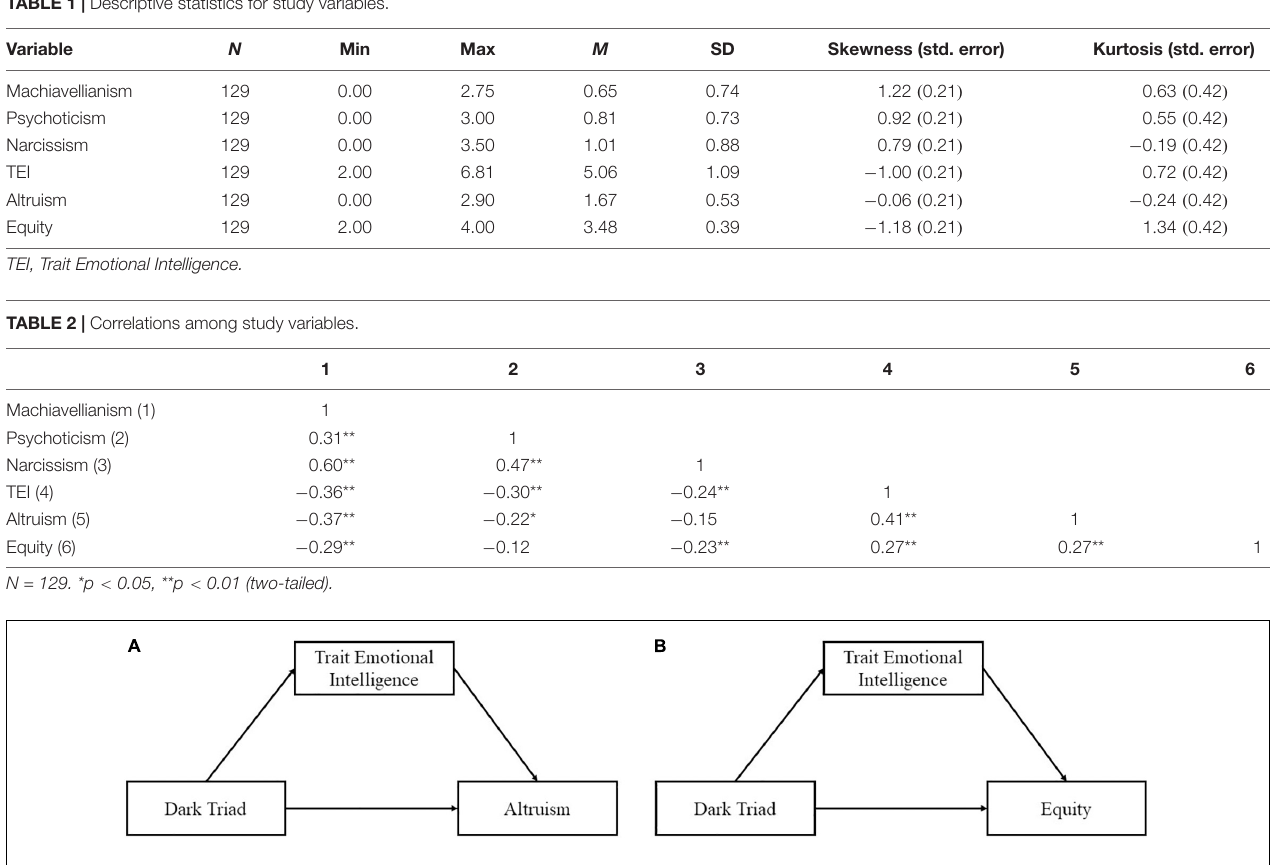
FIGURE 1 | The mediating models advanced in this study, including the dark triad as the independent variable, Trait Emotional Intelligence (TEI) as the mediator, and altruism and equity as the outcomes. (A) TEI significantly mediated the relationship between Machiavellianism and altruism [indirect effect = − 0.05, 95% CI ( − 0.1161, − 0.0189); direct effect = − 0.15, 95% CI ( − 0.2735, − 0.0313); total effect = − 0.21, 95% CI ( − 0.3324, − 0.0897)], between psychoticism and altruism [indirect effect = − 0.07, 95% CI ( − 0.1241, − 0.0274); direct effect = − 0.07, 95% CI ( − 0.2018, − 0.0487); total effect = − 0.14, 95% CI ( − 0.2730, − 0.0231)], and between narcissism and altruism [indirect effect = − 0.04, 95% CI ( − 0.0871, − 0.0100); direct effect = − 0.05, 95% CI ( − 0.1550, 0.0492); total effect = − 0.09, 95% CI ( − 0.2016, 0.0090)]. (B) TEI significantly mediated the relationship between Machiavellianism and equity [indirect effect = − 0.02, 95% CI ( − 0.0661, −